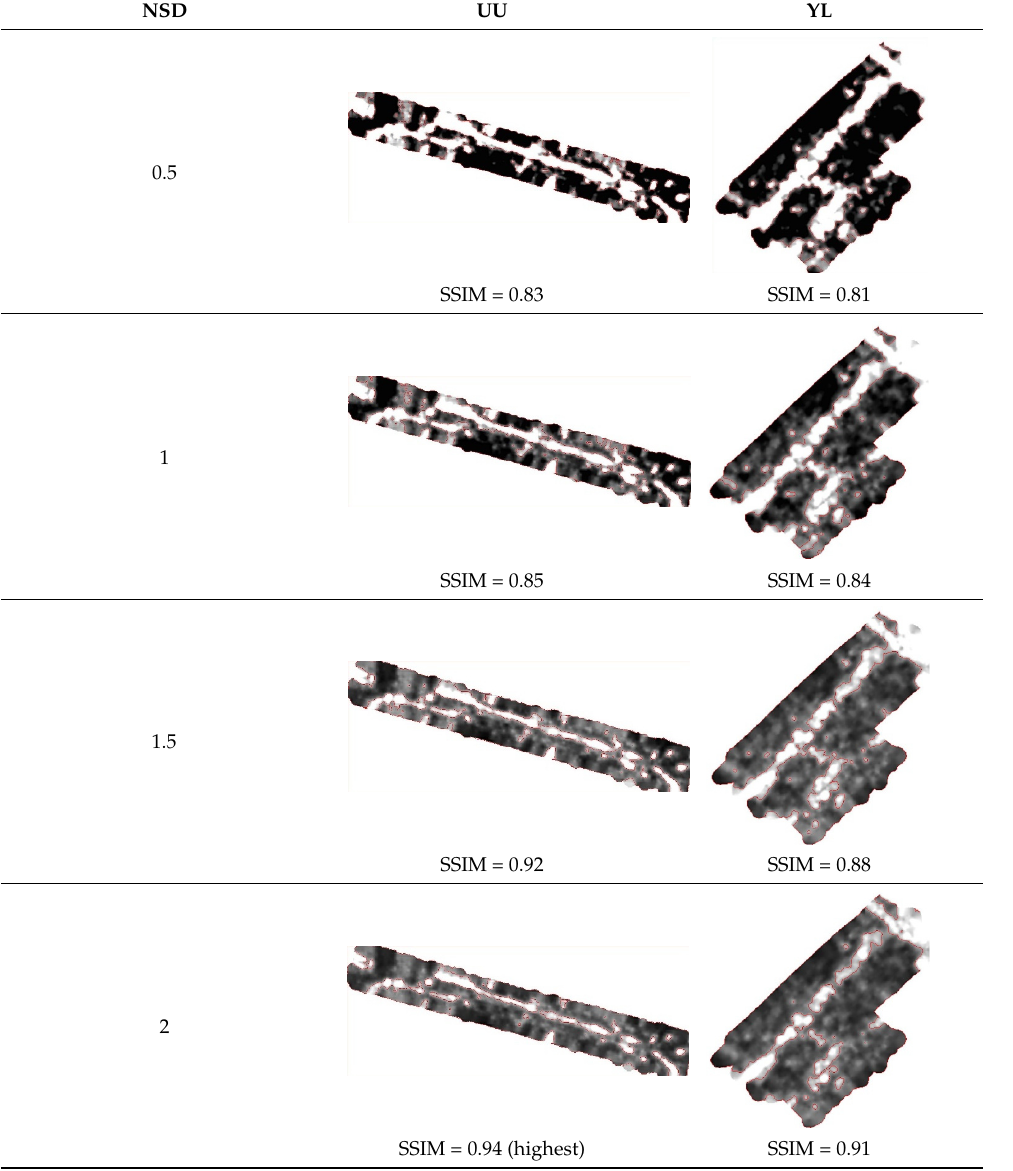
Table 5. Visualisation results of urban underground cases with different greyscales.